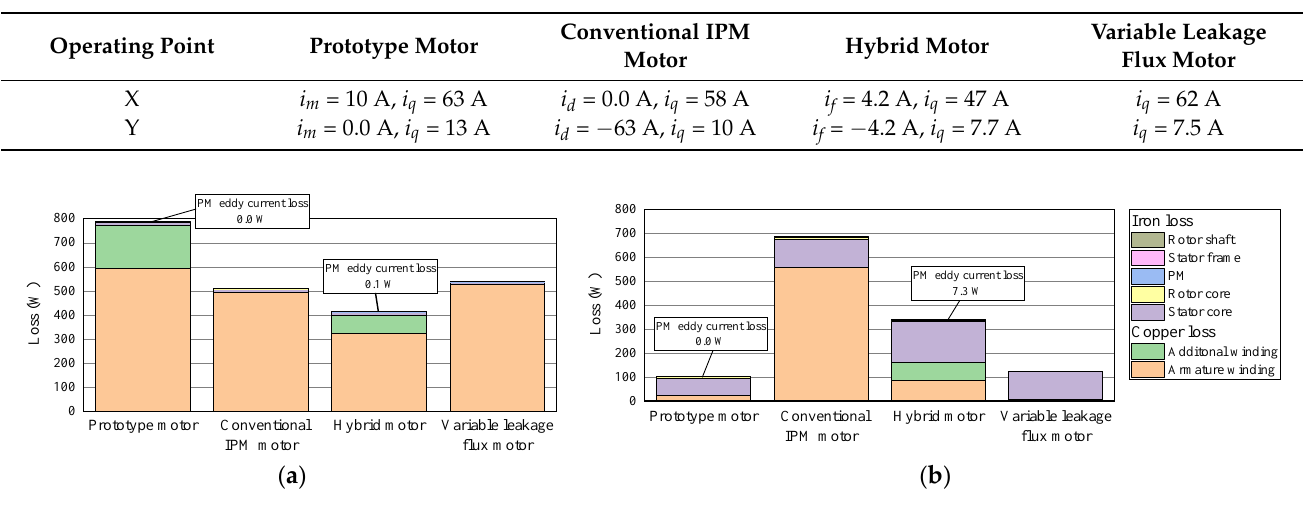
Table 8. Current condition in load analysis.